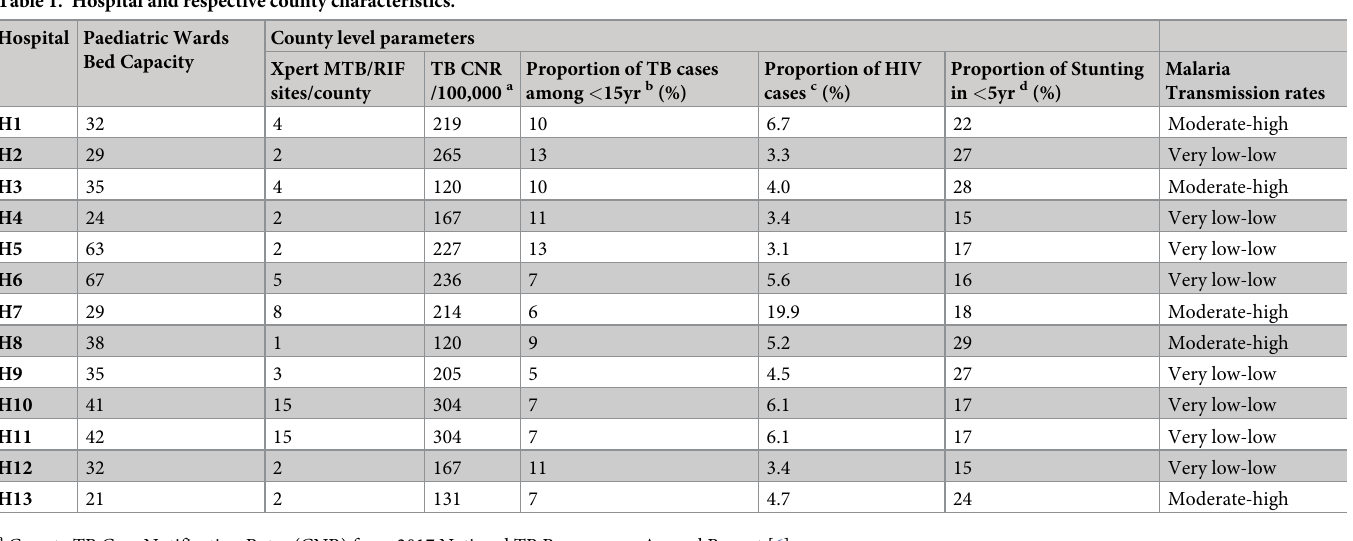
Table 1. Hospital and respective county